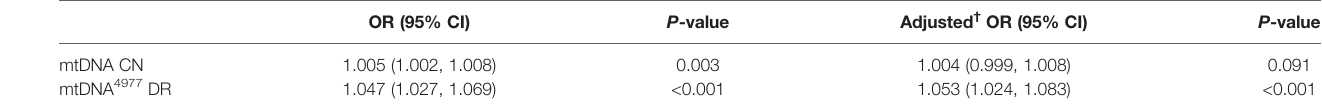
TABLE 2 | ORs and 95% CIs for PCOS with mtDNA biomarkers and metabolic parameters.